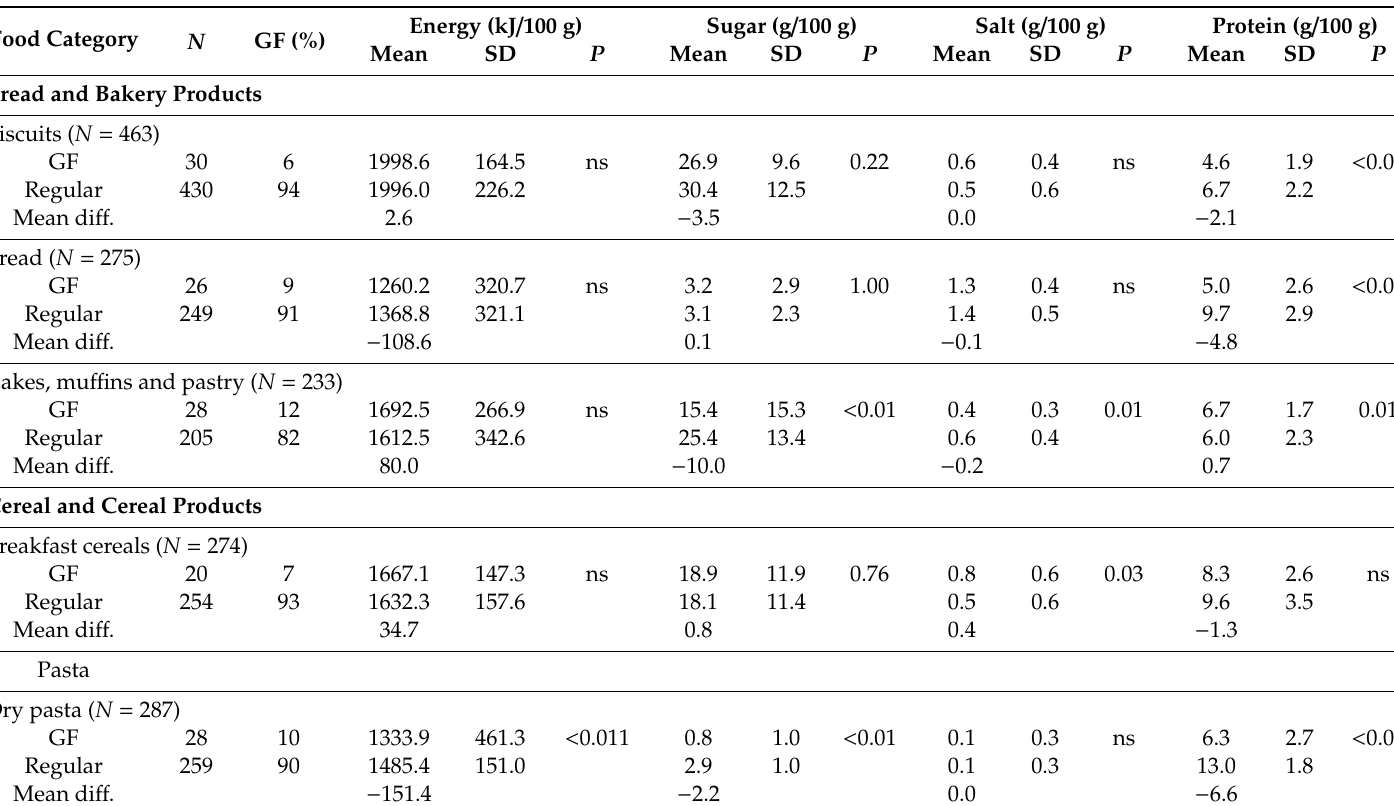
Table 1. Gluten-free (GF) labelled cereal products and comparison of content of energy and certain nutrients in GF-labelled vs. regular products for selected food